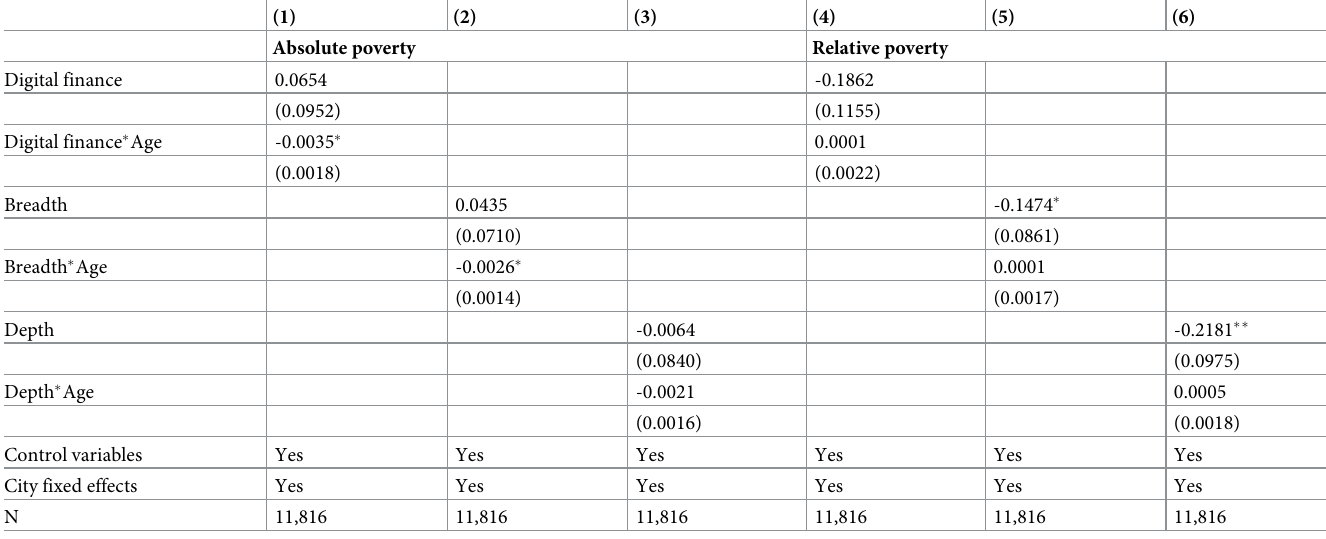
Table 14. Heterogeneity effects by